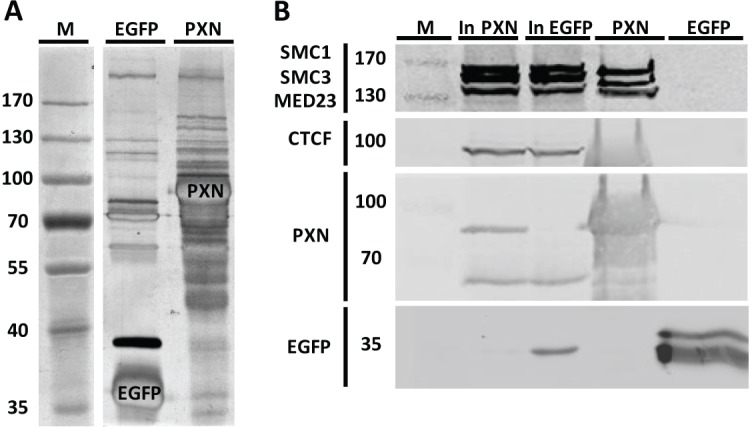
Paxillin binds SMC1, SMC3 and MED23 in the nucleus. (A) A representative gel of a paxillin pulldown stained with silver. HEK293 cells expressing only EGFP with an affinity tag were used as a control. (B) The specificity of the identified interactions was confirmed by western blotting. Cohesin proteins SMC1A (SMC1), SMC3 and MED23 were bound to PXN, but not to the control EGFP. No interaction of paxillin and CTCF was detected. Pulldown fractions from HEK293 cell stably expressing STrEP-EGFP–PXN (PXN) or STrEP-EGFP (EGFP used as a background control) were immunoblotted with the indicated antibodies. Anti-paxillin antibody (PXN) labels both endogenous paxillin (lower bands) as well as recombinant paxillin (upper band). In, input; M, molecular mass markers.